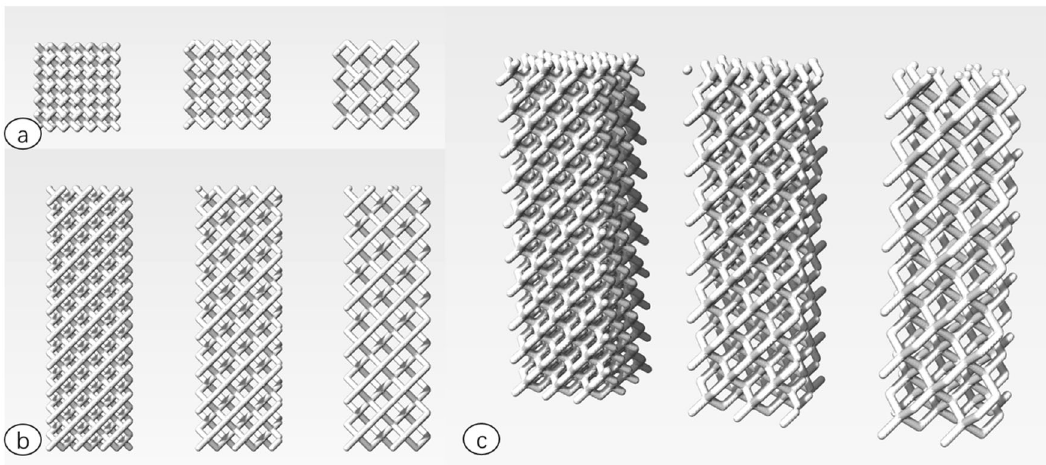
Fig. 1 Three-dimensional model diagram of pore structure (( a ) sagittal plane ( b ) coronal plane ( c ) 3D stereo view (1) diamond structure (2) octahedron structure (3) dodecahedron